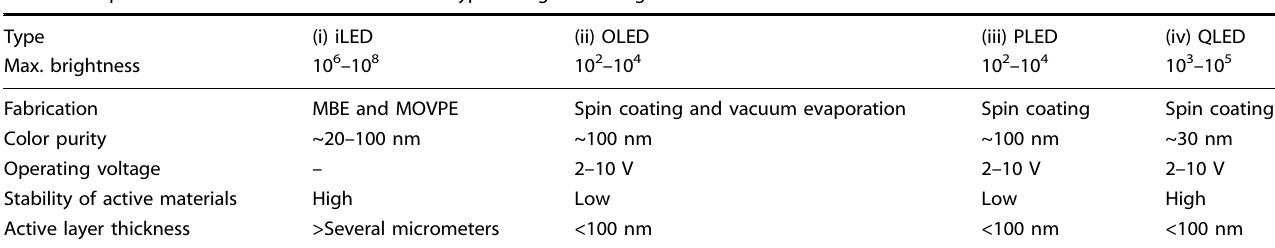
Table 1. Representative characteristics of different types of light-emitting didoes